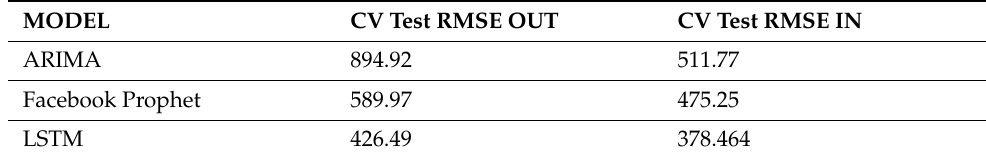
Table 3. Results using recurrent neural network.